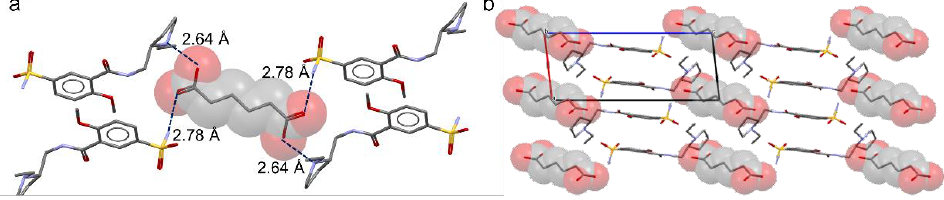
Figure 2. ( a ) Intermolecular interactions established between adipate and surrounding SULP molecules (dashed blue lines). ESDs are omitted for the sake of clarity. ( b ) Crystal packing of SULP-ADPA along the (010) direction. Color code C = grey, N = blue, O = red, S = yellow. ADPA ions are highlighted with spacefill style shadow. Hydrogen atoms are omitted for the sake of clarity.